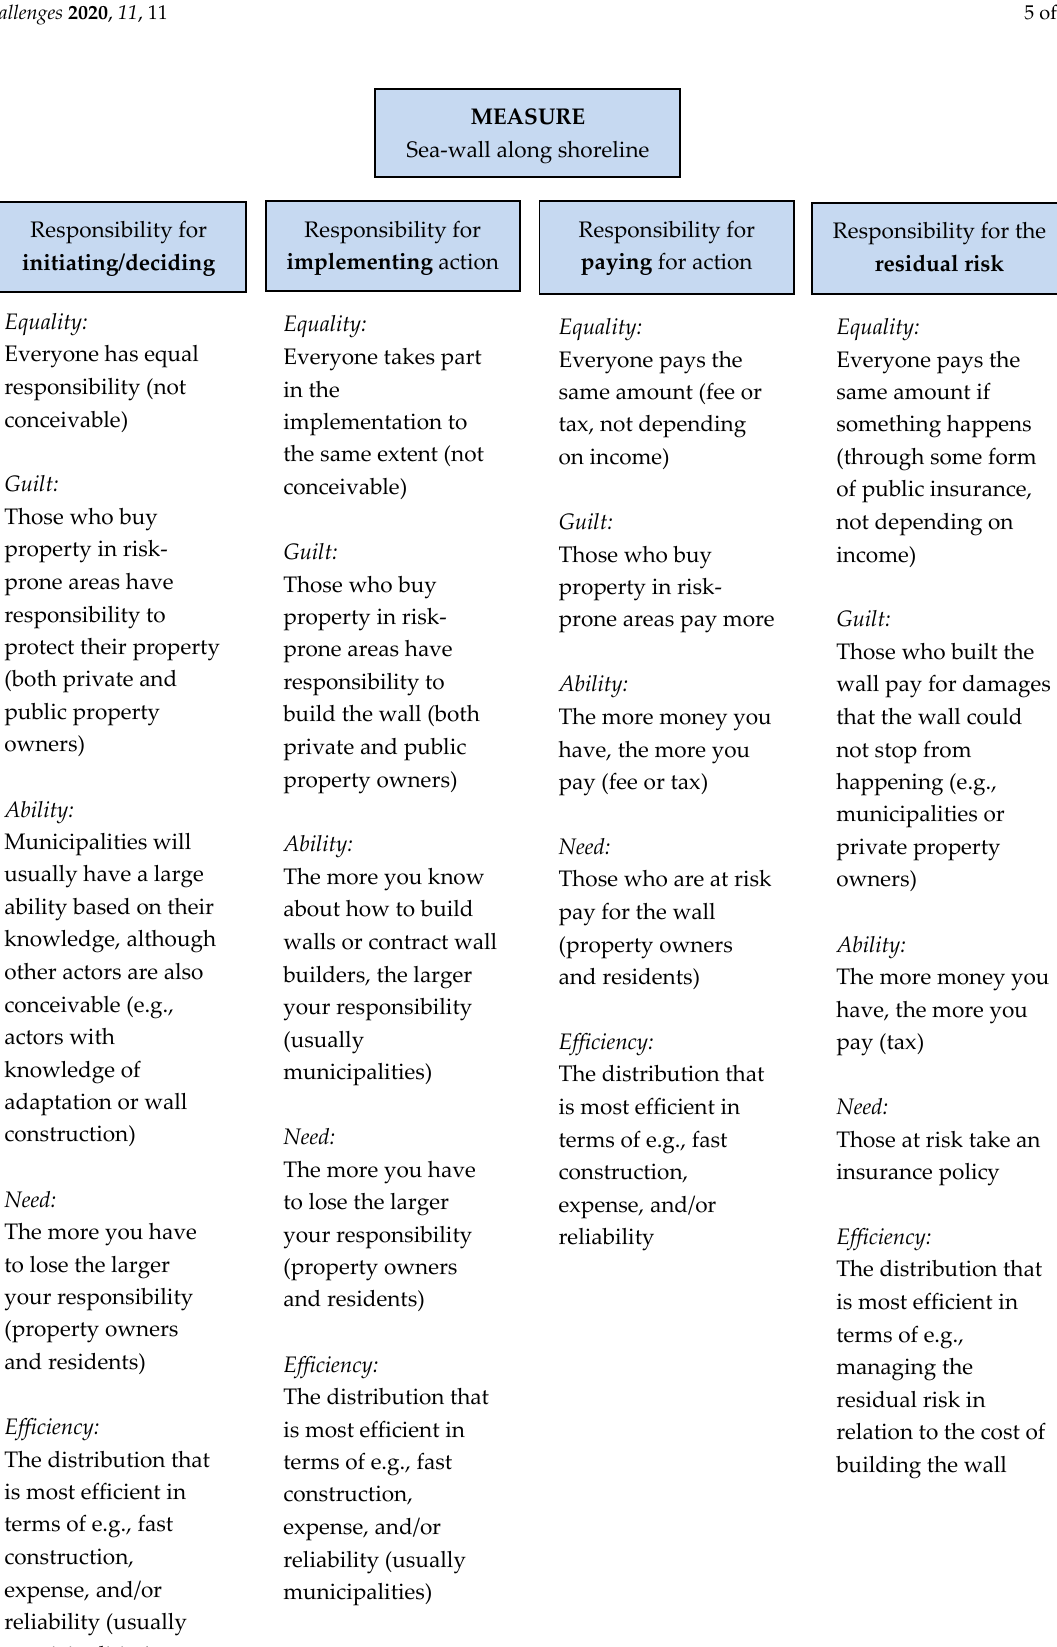
Figure 2. Example of the analysis of the possible responsibility distribution based on the five normative principles.